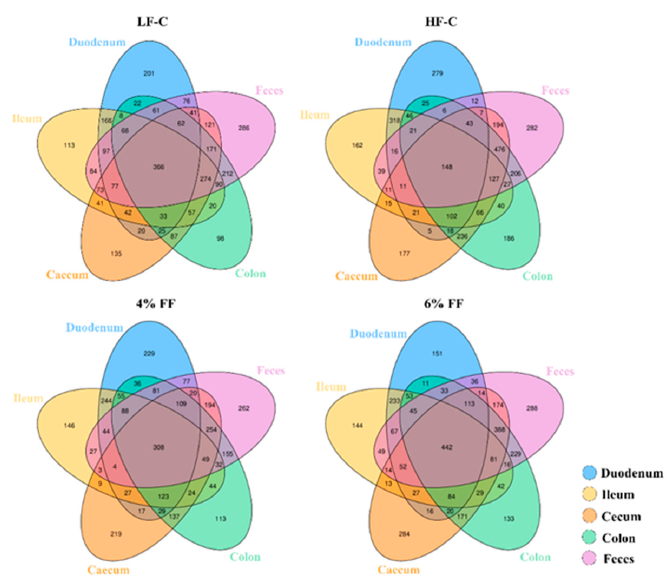
Figure 1. Venn diagram of common and unique OTUs in intestinal microbiota in different intestinal contents and feces.